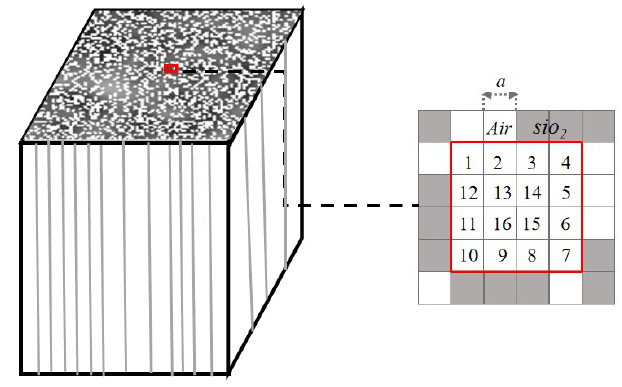
Figure 1. Schematic cross-sectional structure of G-DOF.